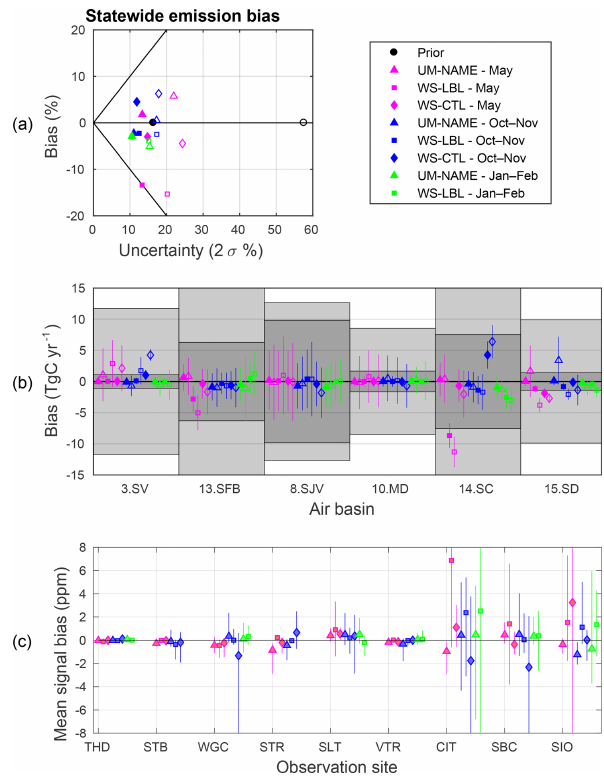
Figure 5. (a) Statewide and (b) individual air basin inversion results for an error in the temporal distribution of prior emissions. Prior emissions are given by temporally varying Vulcan and true emis- sions are given by annually averaged Vulcan. Prior emissions were scaled to be equal in magnitude to annually averaged Vulcan emis- sions; (c) shows the mean signal error in simulated average ffCO 2